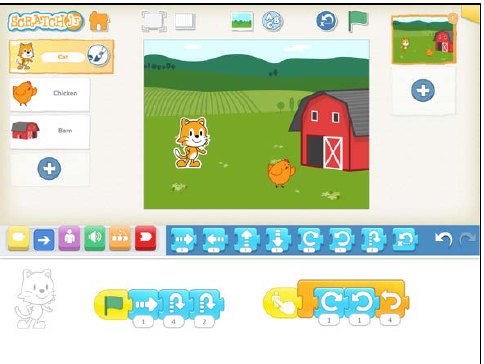
Figure 1. This image shows the programming app